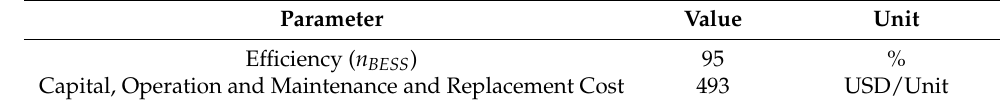
Table 2. BESS cost parameters. Parameter Value Capital, Operation and Maintenance and Replacement Cost